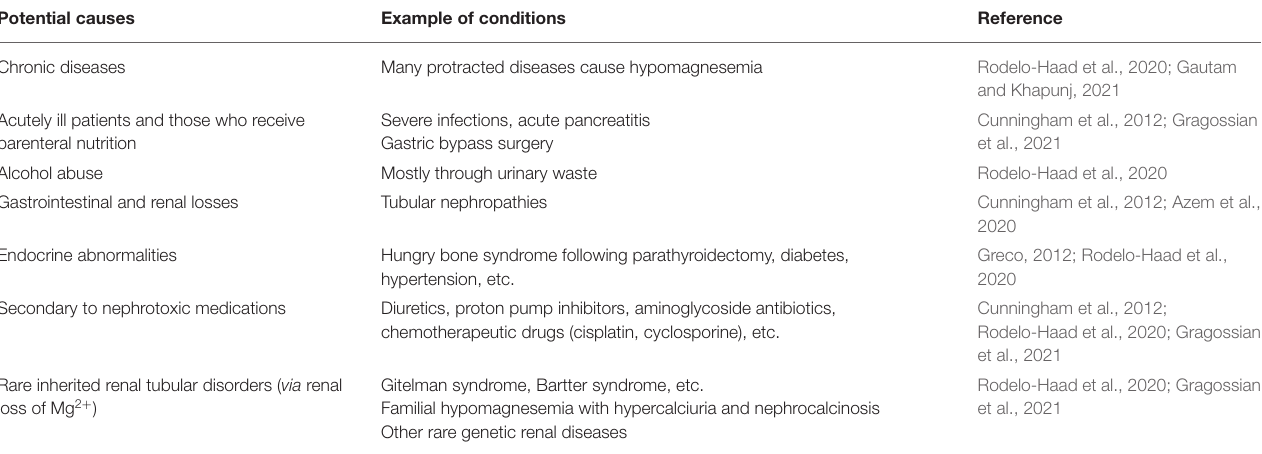
TABLE 2 | Causes that lower tissue and/or serum magnesium concentrations in persons with CKD. Potential